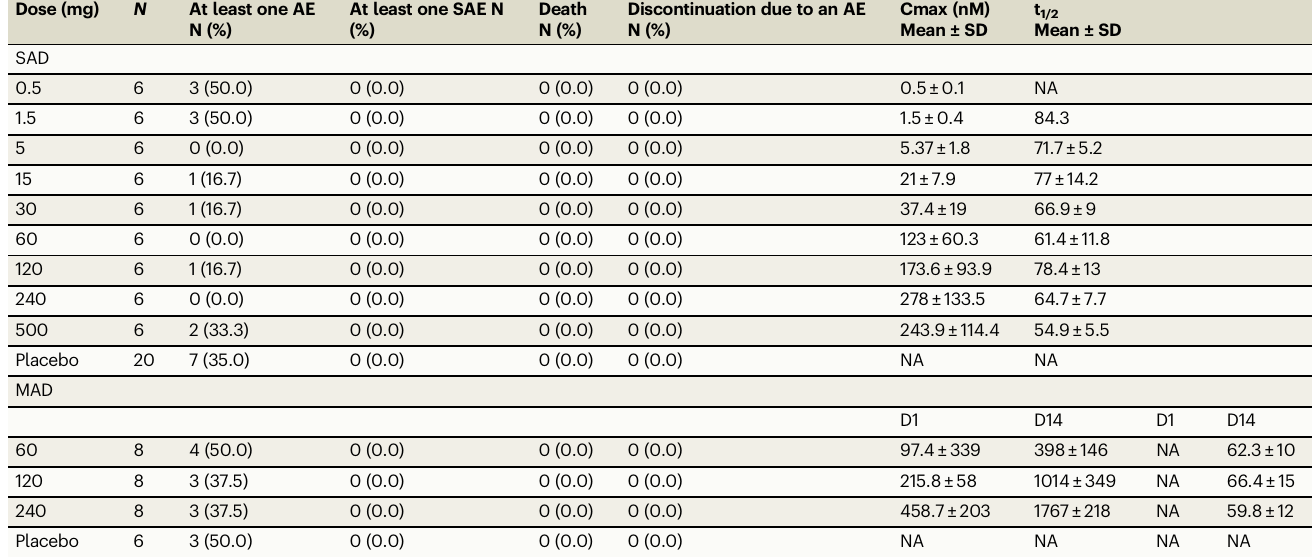
Table 2 | Safety and pharmacokinetics of TD-6450 in phase I clinical